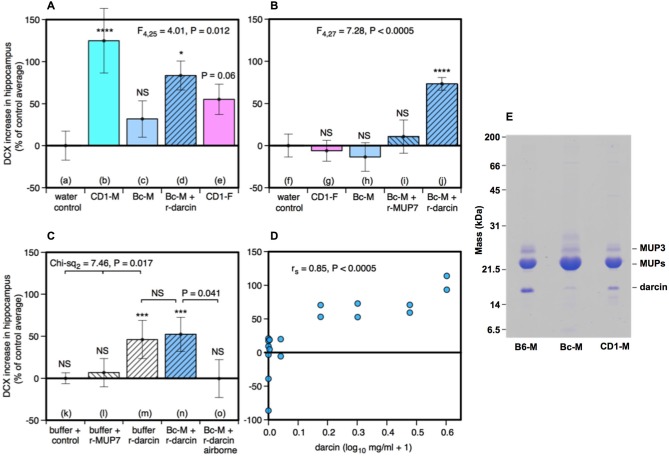
Effect of the darcin pheromone on hippocampal neurogenesis in females. Increase in DCX-positive cell counts in the dentate gyrus of females exposed to treatment scents for 7 days in their home cages (mean ± sem, n = 6 per treatment group), expressed as a percentage of the control treatment average for that experiment (A,B) water; (C) recombinant buffer; (D) BALB/c male urine). Females had full contact with urine stimuli (A: b–e, B: g–j, C: n), 1 μg/μl recombinant darcin or MUP7 control (C: l, m); a mixture of 1 μg/μl recombinant MUP and urine with full contact (A: d, B: i, j, C: n) or with access to airborne odor only (C: o). CD1-M: CD-1 male urine; Bc-M: BALB/c male urine; CD1-F: CD-1 female urine; B6-M: C57BL/6 male urine. ANOVA analyses established differences between treatments within each experiment (A,B) parametric, (C) non-parametric), with planned comparison of each scent treatment to the control group (*P < 0.05, **P < 0.01, ***P < 0.005, ****P < 0.001). Relationship between contact with different concentrations of darcin added to BALB/c male urine (n = 6 females at 0 μg/μl, n = 2 females at 0.01, 0.1, 0.5, 1, 2, 3 μg/μl) and DCX-positive cell count assessed using Spearman rank correlation (D). SDS-PAGE illustrating differing amounts of darcin in male urine from different laboratory strains relative to the main MUPs band, with 5 μg protein loaded for each strain (E). Darcin runs abnormally quickly on SDS-PAGE (Armstrong et al., 2005) while MUP3 is glycosylated and runs more slowly than other MUPs. By loading a large amount of protein, the very small amount of darcin in BALB/c male urine (<0.5%) is evident, though below threshold for response.